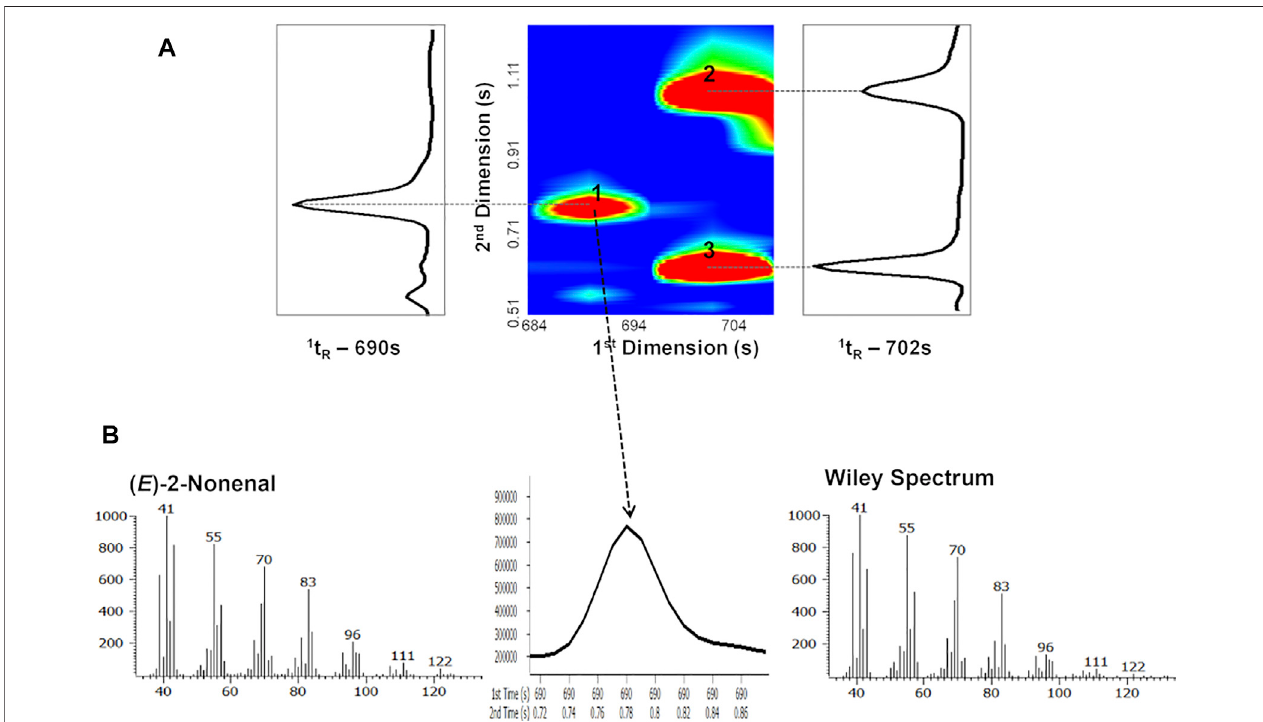
FIGURE 9 | (A) Blow-up of a part of GC × GC chromatogram contour plot of Lager beer (obtained from Figure 8 ) showing the separation of 1) ( E )-2-nonenal, 2) ethyl benzoate, and 3) 2-nonen-1-ol. (B) The 49-ms-wide ( E )-2-nonenal (trace beer metabolite) GC × GC peak is easily de fi ned and identi fi ed at a mass spectral acquisition of 125 spectra/s and its spectral quality allows its identi fi cation by comparison with mass spectrum of commercial database. Figure adapted from Martins et al. (2017).